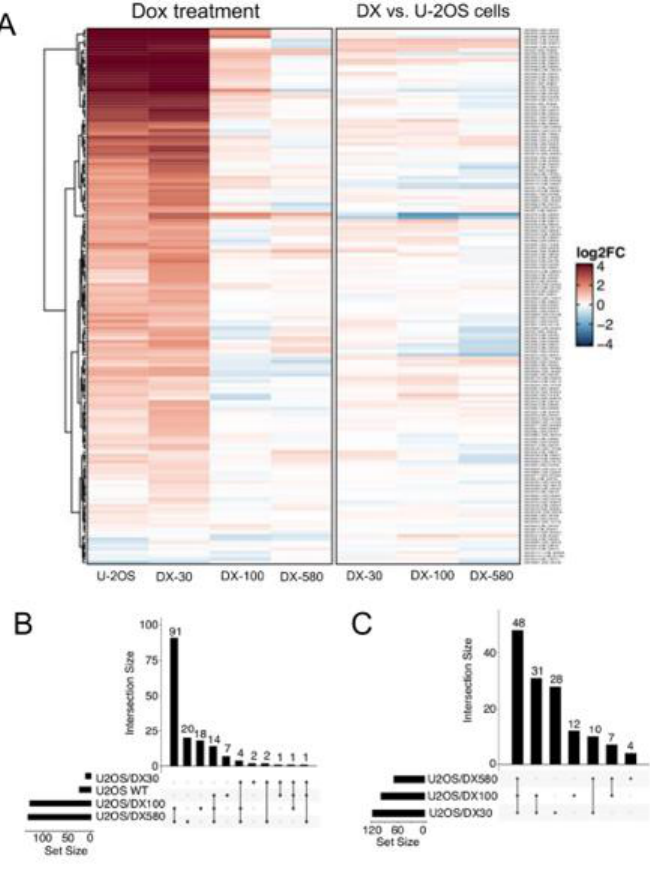
Figure 1. snoRNA family is up-regulated upon doxorubicin treatment and in doxorubicin-resistant osteosarcoma cells. ( A ) Heatmap of snoRNA expression changes upon 5 μM Dox treatment for 24 h, in Dox-sensitive U-2OS cells and Dox-resistant variants (U-2OS/DX30, U-2OS/DX100 and U-2OS/DX580) (left) or computed between U-2OS cells and resistant variants (right). ( B ) UpSet plot reporting the overlap between snoRNA significantly and differentially expressed upon Dox treatment in sensitive and resistant cells ( C ) UpSet plot reporting the overlap between snoRNA upregulated in Dox-resistant variants compared to Dox-sensitive cells. The results are the means of two independent experiments.